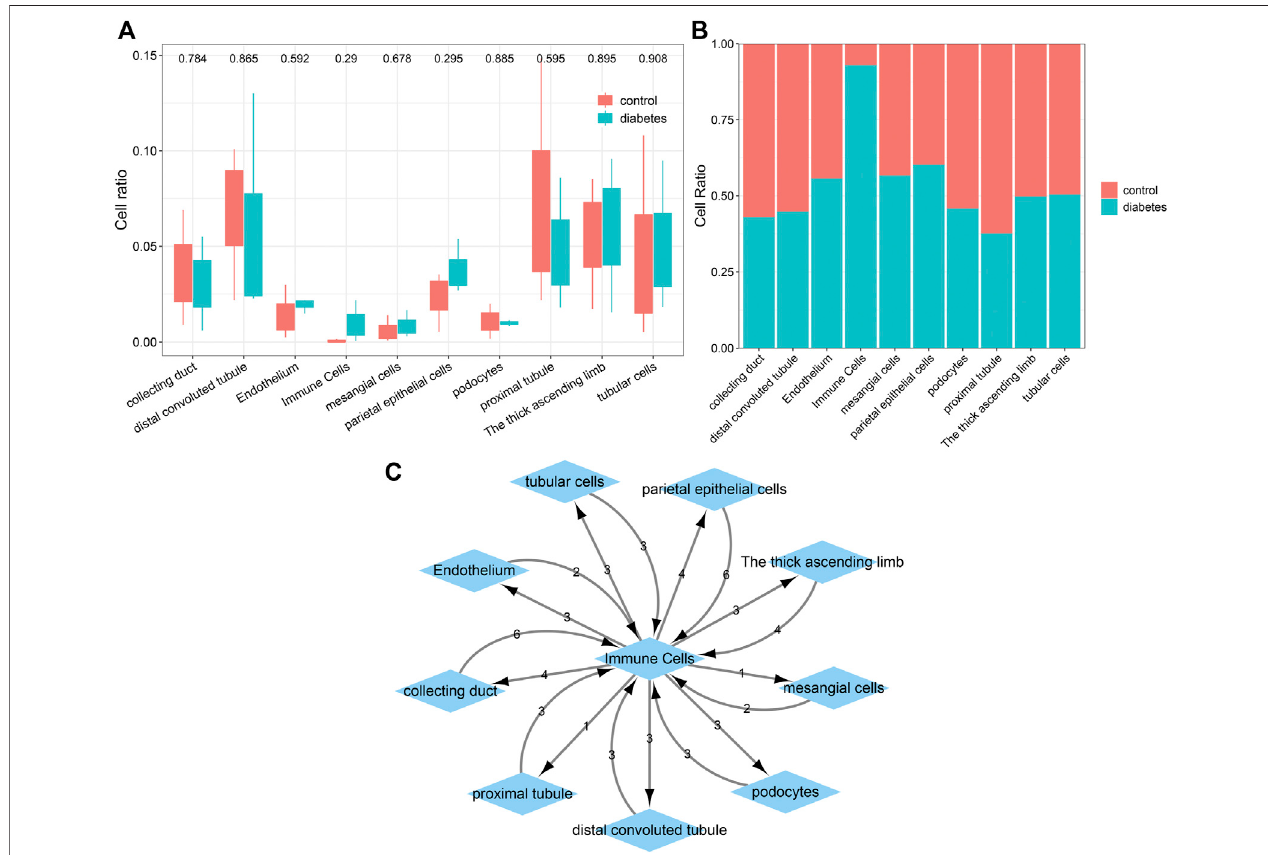
FIGURE 6 | Comparisons of the difference in various cell types between diabetic kidney specimens and controls and the establishment of a ligand – receptor network. (A) Boxplotsshowing thedifferences in thecellratios ofcollecting duct, distalconvolutedtubule,endothelium,immunecells,mesangialcells, parietalepithelial cells, podocytes, proximal tubule, the thick ascending limb, and tubular cells between the diabetic kidney specimens and controls. (B) Stacked graph for the cell ratios among the aforementioned cell types both in diabetic kidney specimens and controls. (C) The ligand – receptor network among the aforementioned cell types. The number represents the number of relationship